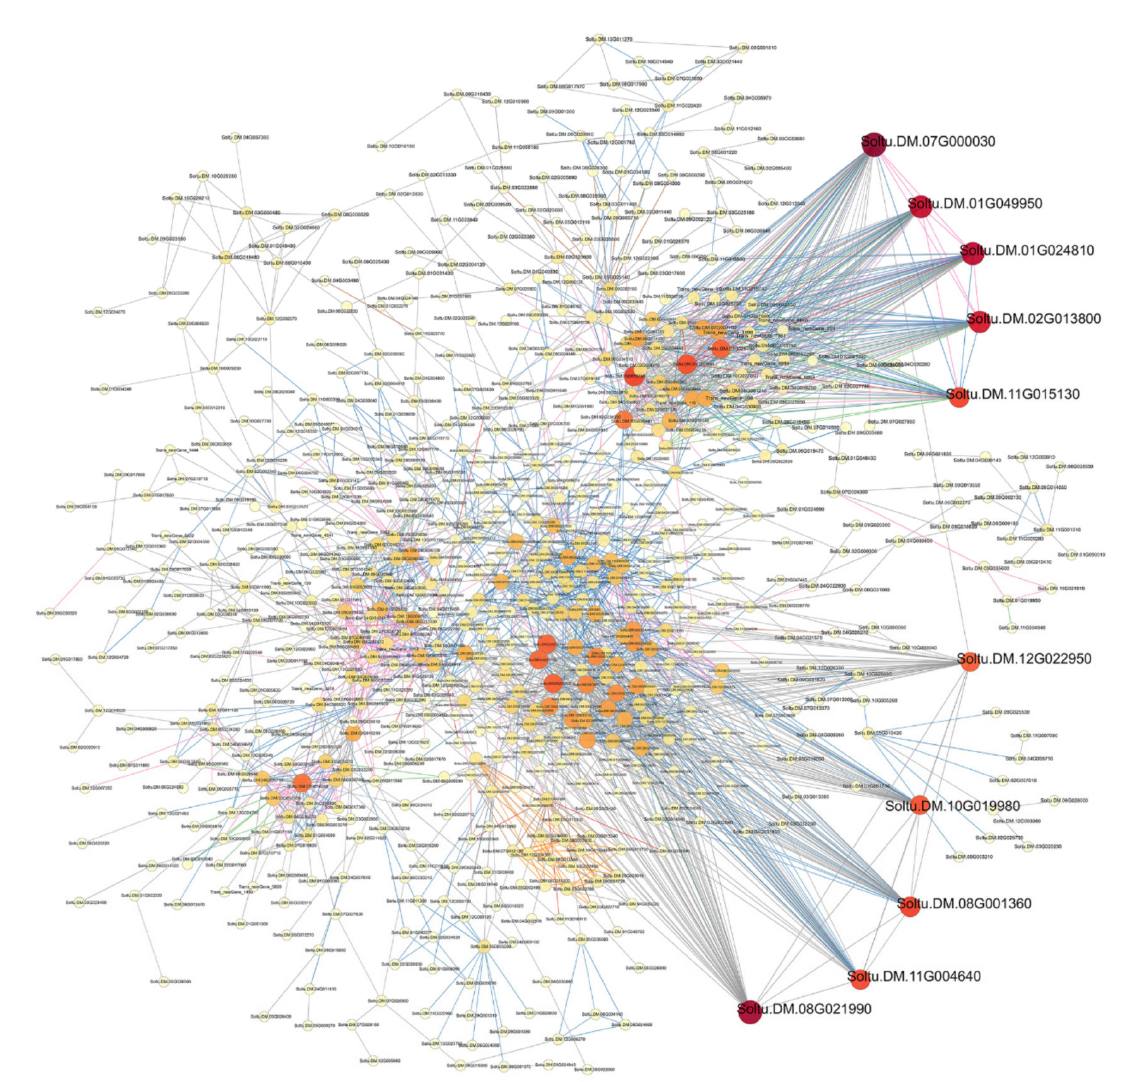
Figure 7. A PPI (protein–protein interaction) network of DEGs from variety A versus Q under dual treatment for 2 h. The interaction relationship in the STRING protein interaction database (http: //string-db.org/ accessed on 6 September 2021) was then used to analyze the DEG coding protein in- teraction network. The ID of key hubs corresponding proteins were as follows: